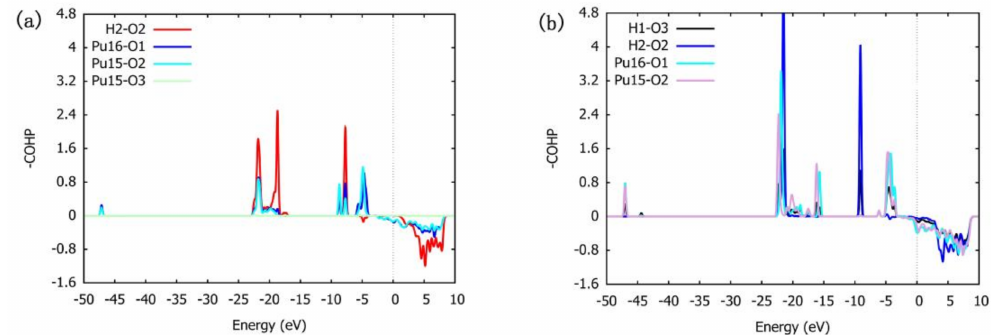
Figure 12. The COHP between adjacent atoms in the two most stable adsorption configurations. ( a ) BH-S-H4O10 ( b ) B-S-H2O4 (dotted line in the figure indicates where Fermi level is located).